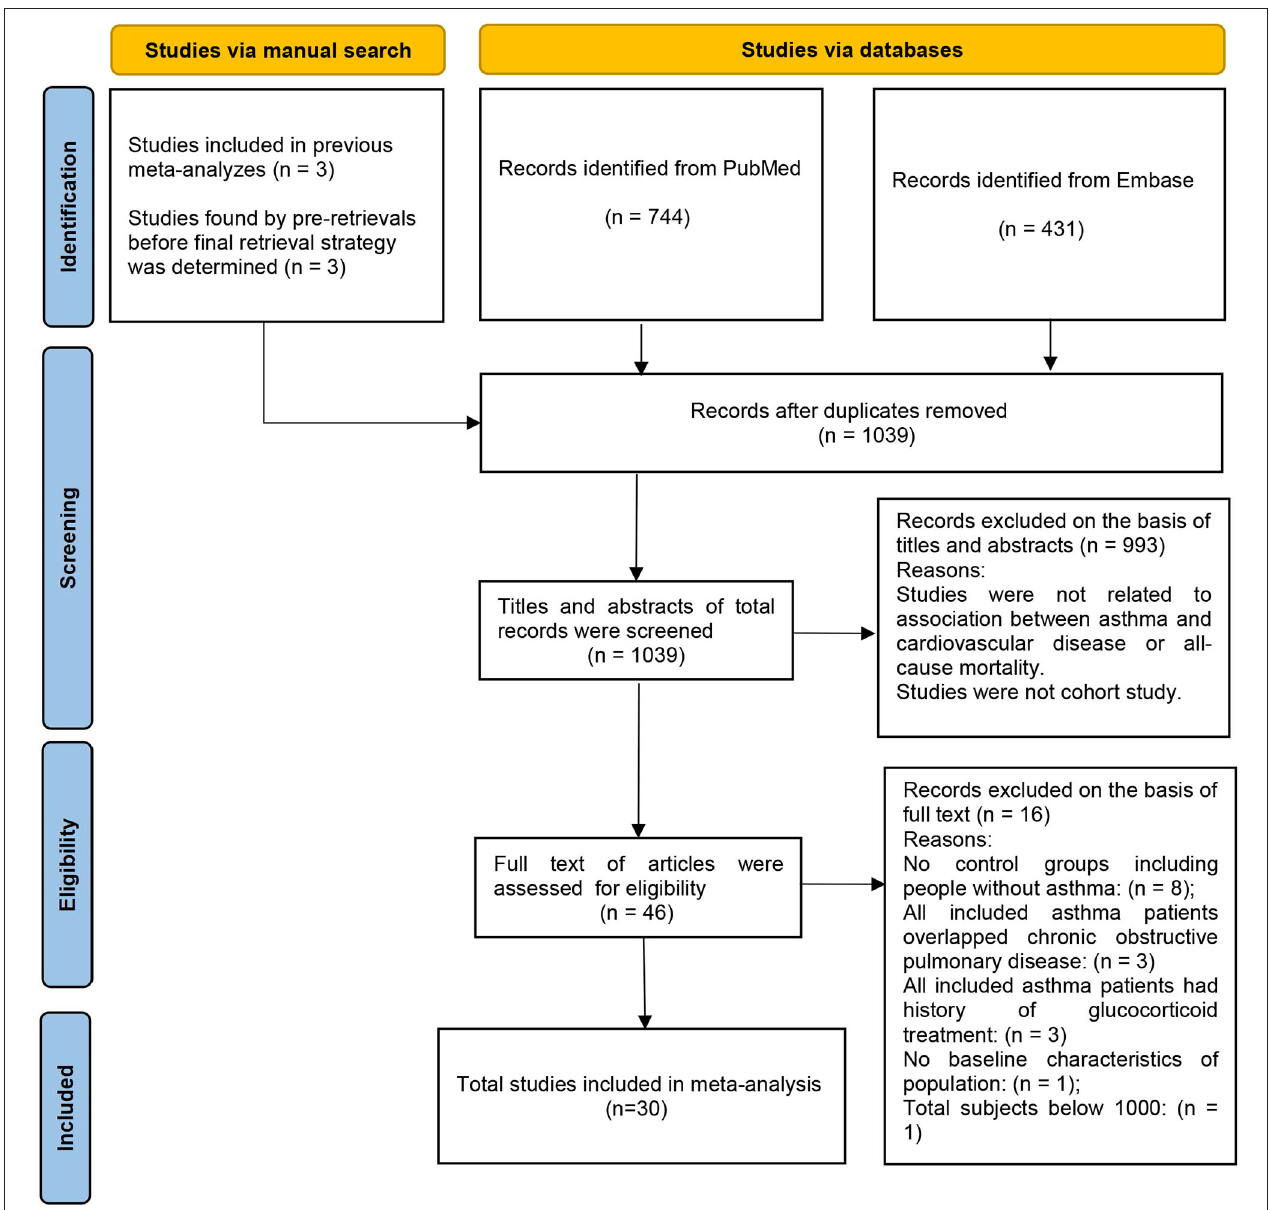
FIGURE 1 | Flow chart of article selection